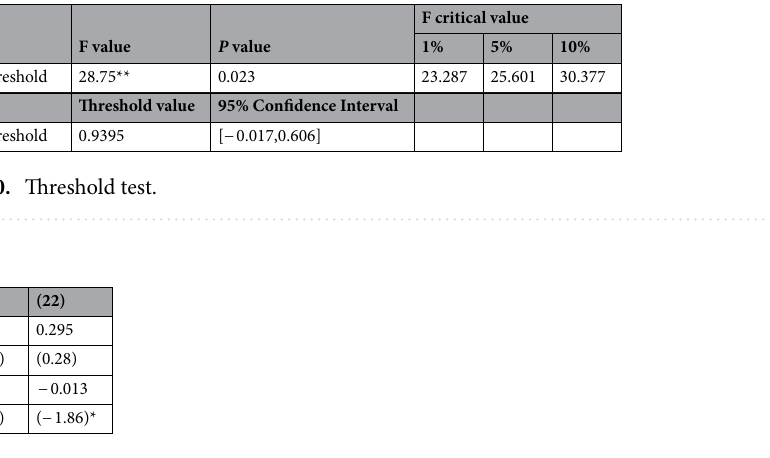
Table 11. Threshold effect estimation results.